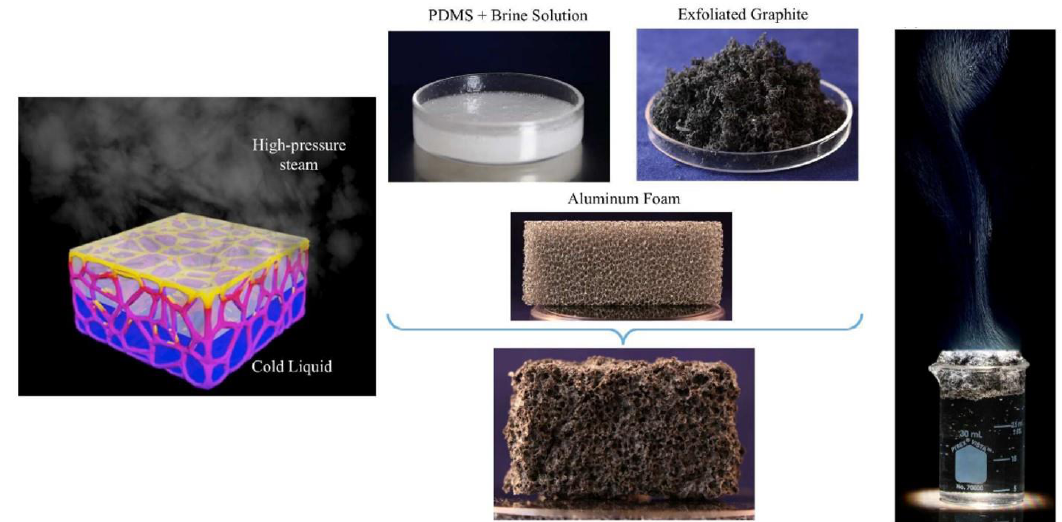
Figure 28. Schematics of flexible artificially networker floating surface absorbing evaporators [91]; 2016, RSC.